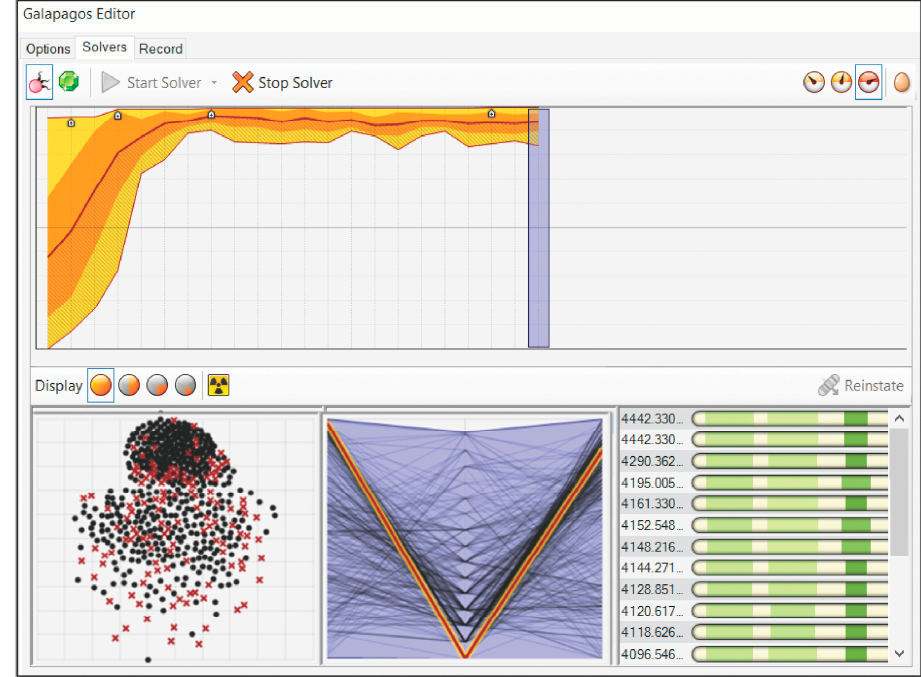
Figure 5. Galapagos optimization results. At the top of the figure, the graph about the solutions convergence is presented. At the bottom, the comparison between solutions with a scatter plot graph and the optimized solution in a parallel coordinate plot are presented.